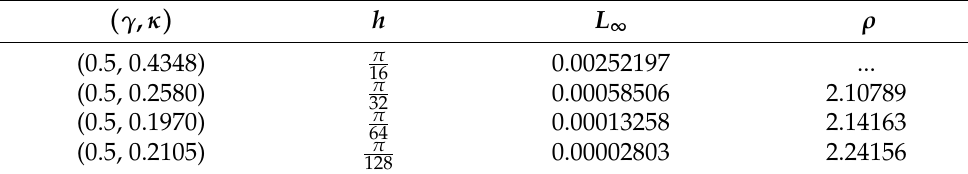
Table 5. The L ∞ error norm and ρ of Example 1 when K =